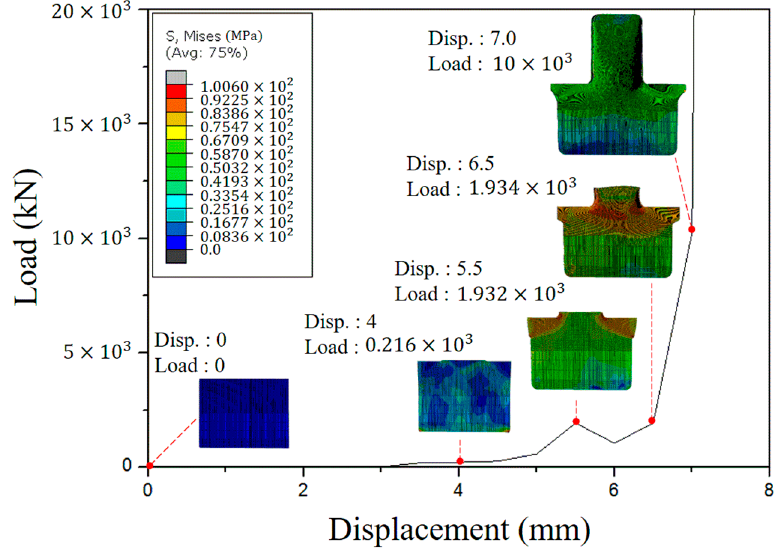
Figure 11. Load–displacement curve obtained by simulation result of hot extrusion.